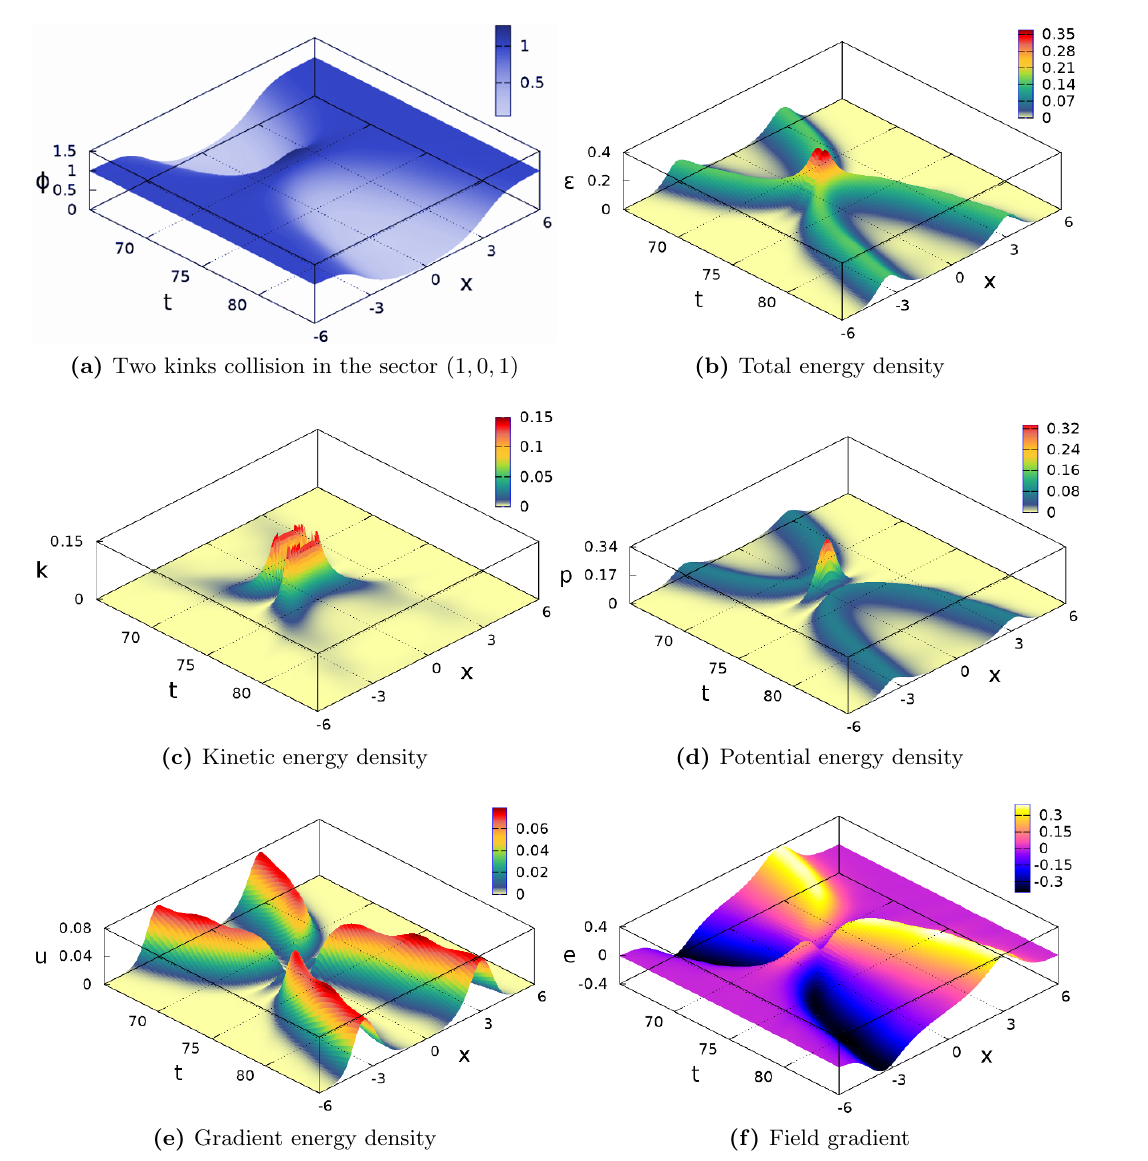
Figure 4. Space-time picture of collision of two kinks in the case of initial con(cid:12)guration (1 ; 0 ; 1).